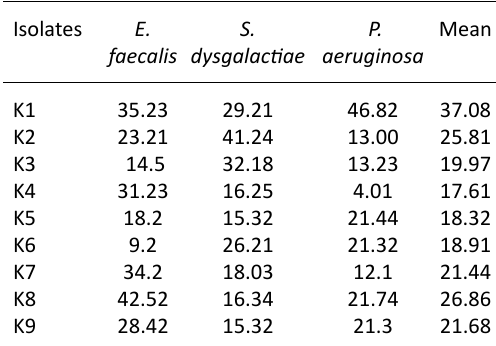
Table 4. Effect of different pH on strains at OD 620 nm No. Isolate pH2